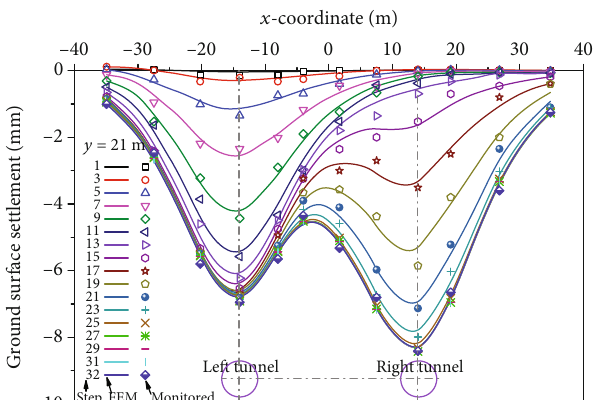
Figure 6: Ground surface settlement troughs at y = 21 m by the fi nite element method (FEM) and in situ